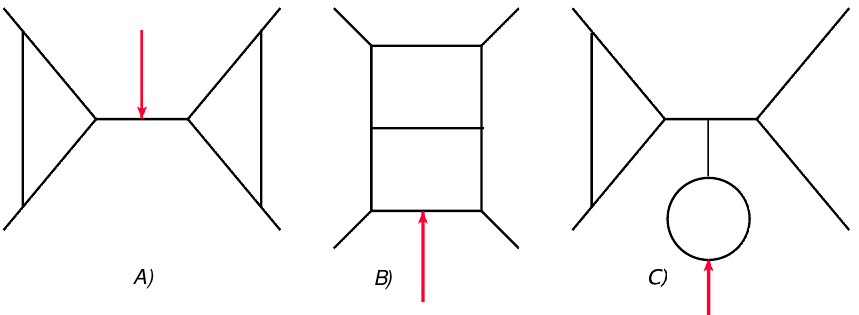
Figure 7 . Different possible types of pole contributions to loop BCFW recursion. Here we depicted scalar integrals for two loop n = 4 example. Red arrows indicate propagators which we are cutting when evaluating residues. Term C) is actually absent in